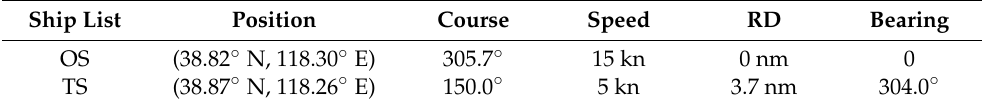
Table 4. Initial information (head-on).